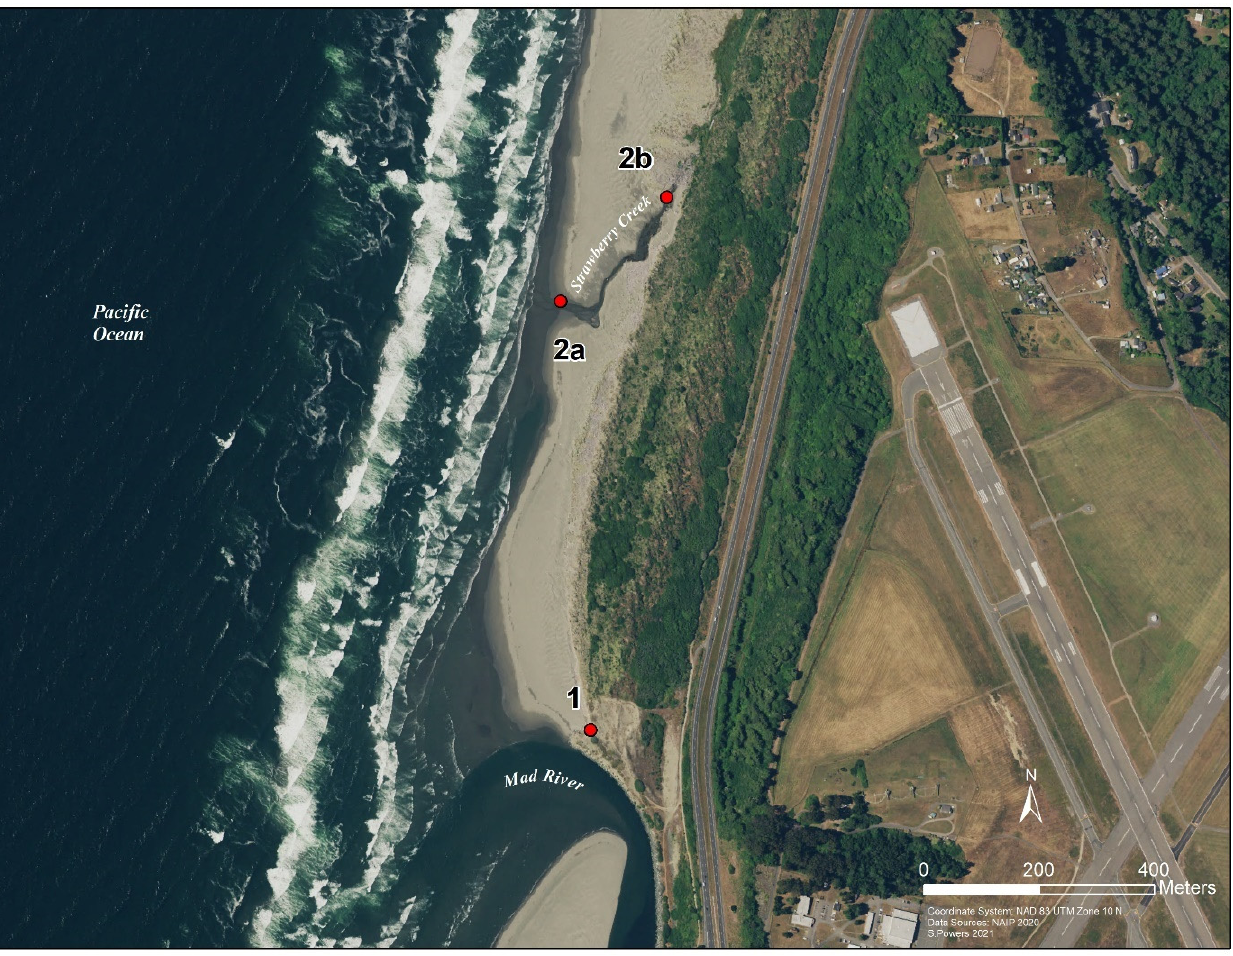
Figure 2. GIS map of the study area showing the three collection sites along Clam Beach. Site 1 at Mad River, site 2a in the mixing zone of Clam Beach and Strawberry Creek, and site 2b upstream Strawberry Creek. County of Humboldt GIS. Per week, typically 17 samples per sampling event. At least 100 mL of water were collected in a DNA-Free Falcon sterile collection container using a sampling pole. All samples were transported to the lab.